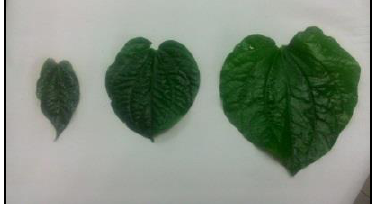
Figure 1: From left; young leaf, middle-age leaf and old